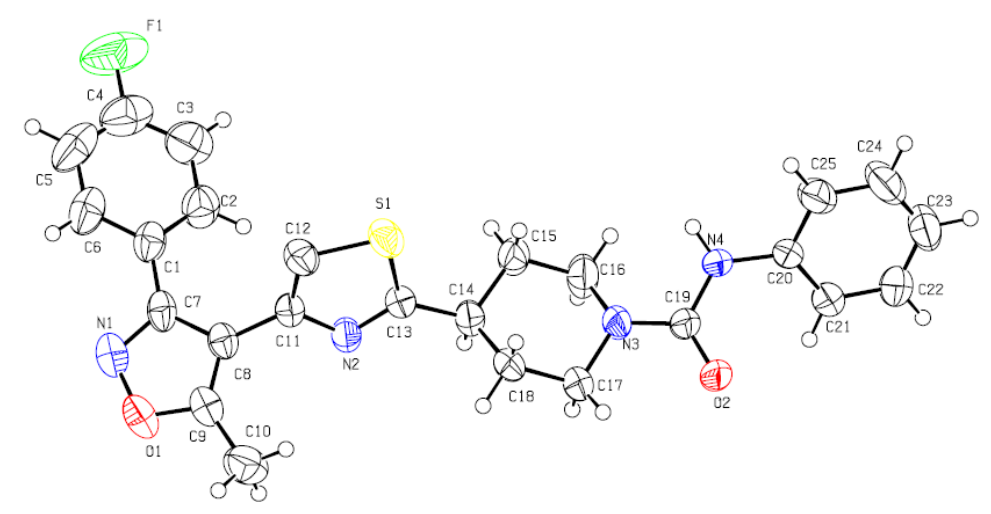
Figure 2 . Molecular structure of compound 4j